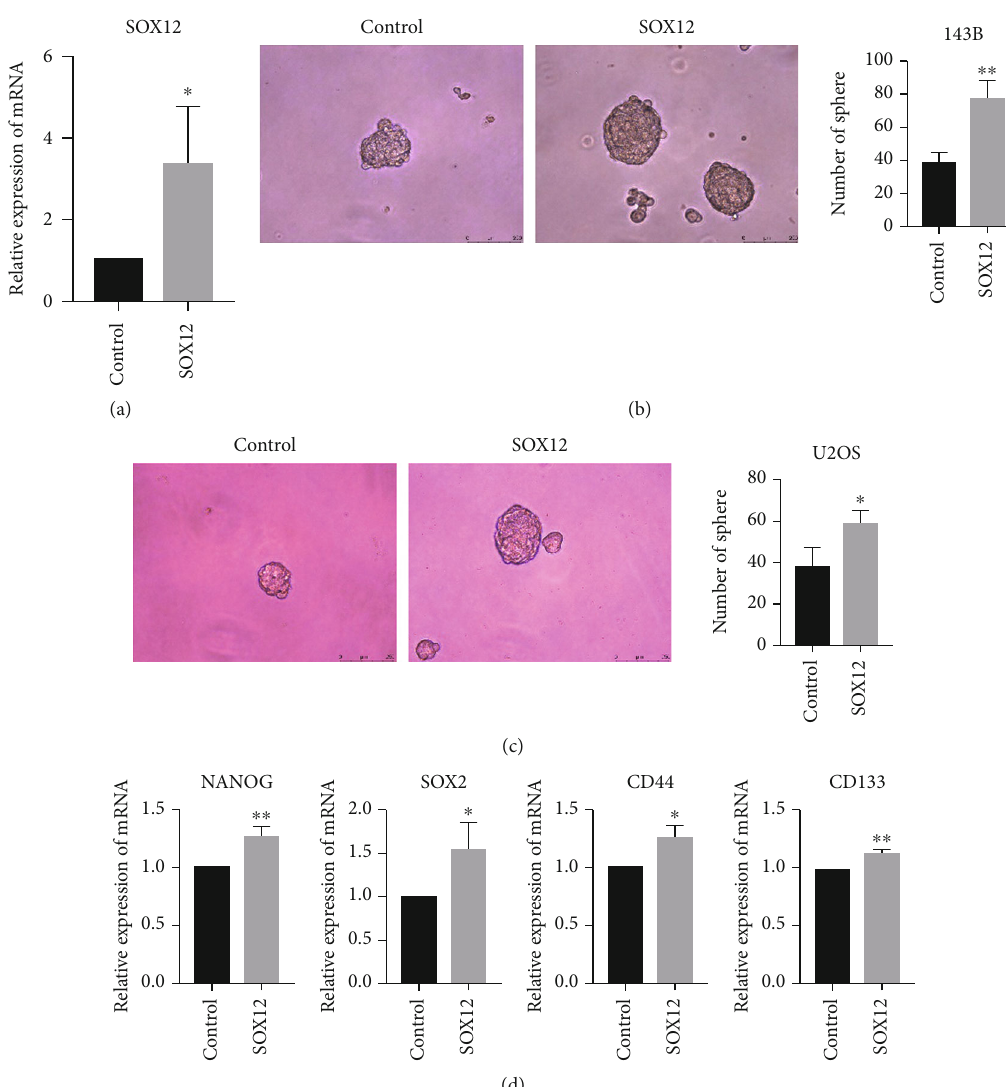
Figure 5: SOX12 overexpression promotes the stem cell-like properties of osteosarcoma cells. (a) Transfection of SOX12 plasmid increased SOX12 mRNA in 143B cells. (b) Overexpression of SOX12 enhances the spheroidizing ability of 143B cells. (c) Overexpression of SOX12 enhances the spheroidizing ability of U2OS cells. (d) Overexpression of SOX12 upregulated the stemness markers of 143B